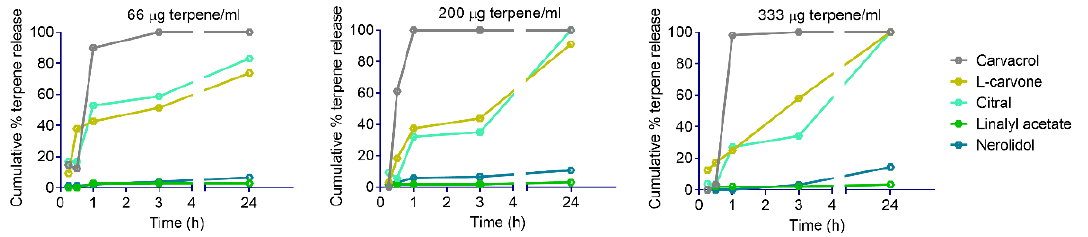
Figure 6. Cumulative terpene release from YP-terpene samples diluted in water at terpene concentrations of 66, 200, and 333 μ g/mL.